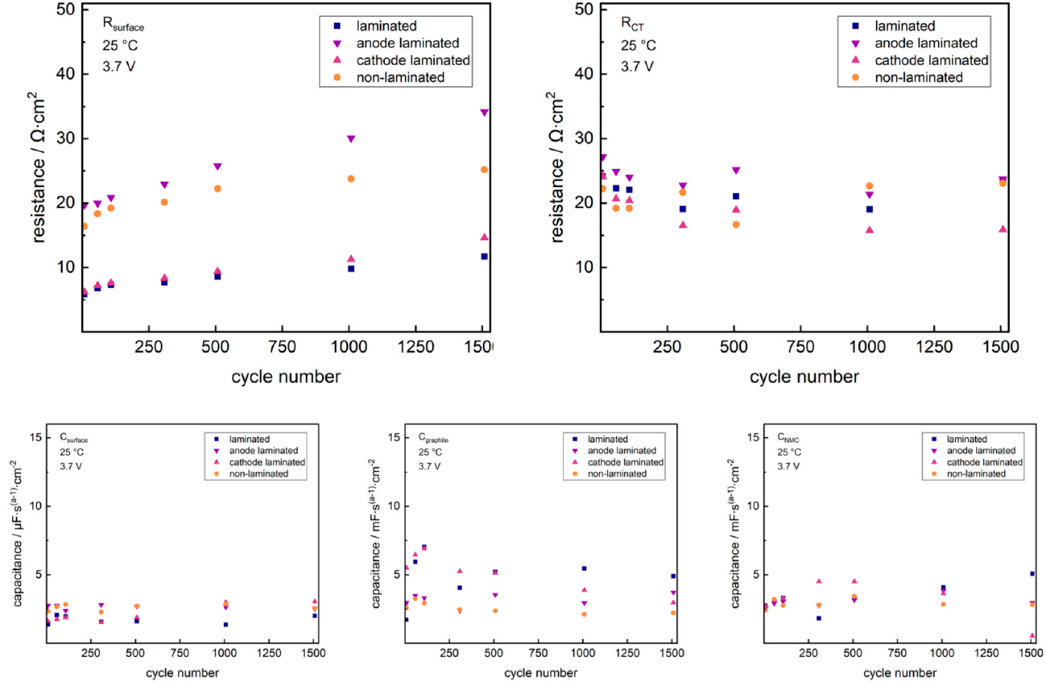
Figure 7. EIS resistance fit parameters of laminated and non-laminated single cells along fast-charging cycles; data normalized to geometric electrode area.